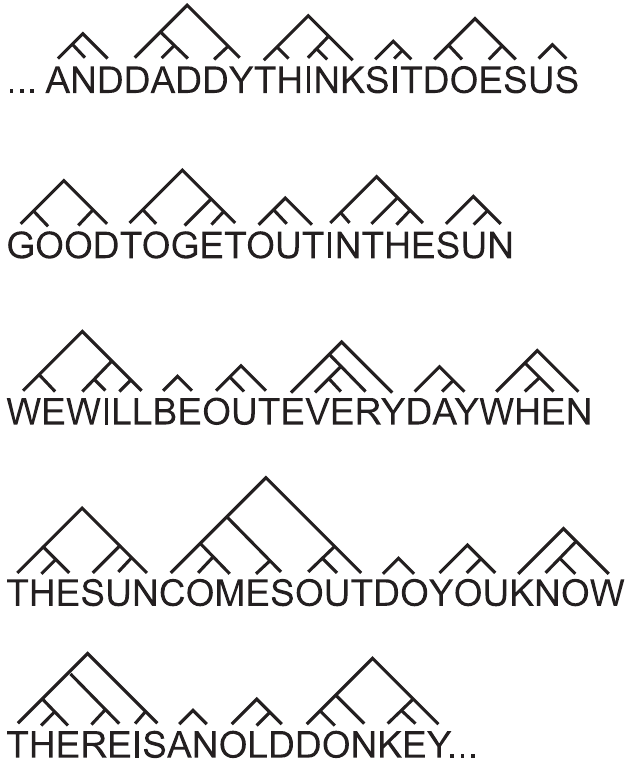
Figure 10. Part of a parsing created by program MK10 [40] from a 10,000 letter sample of English (book 8A of the Ladybird Reading Series) with all spaces and punctuation